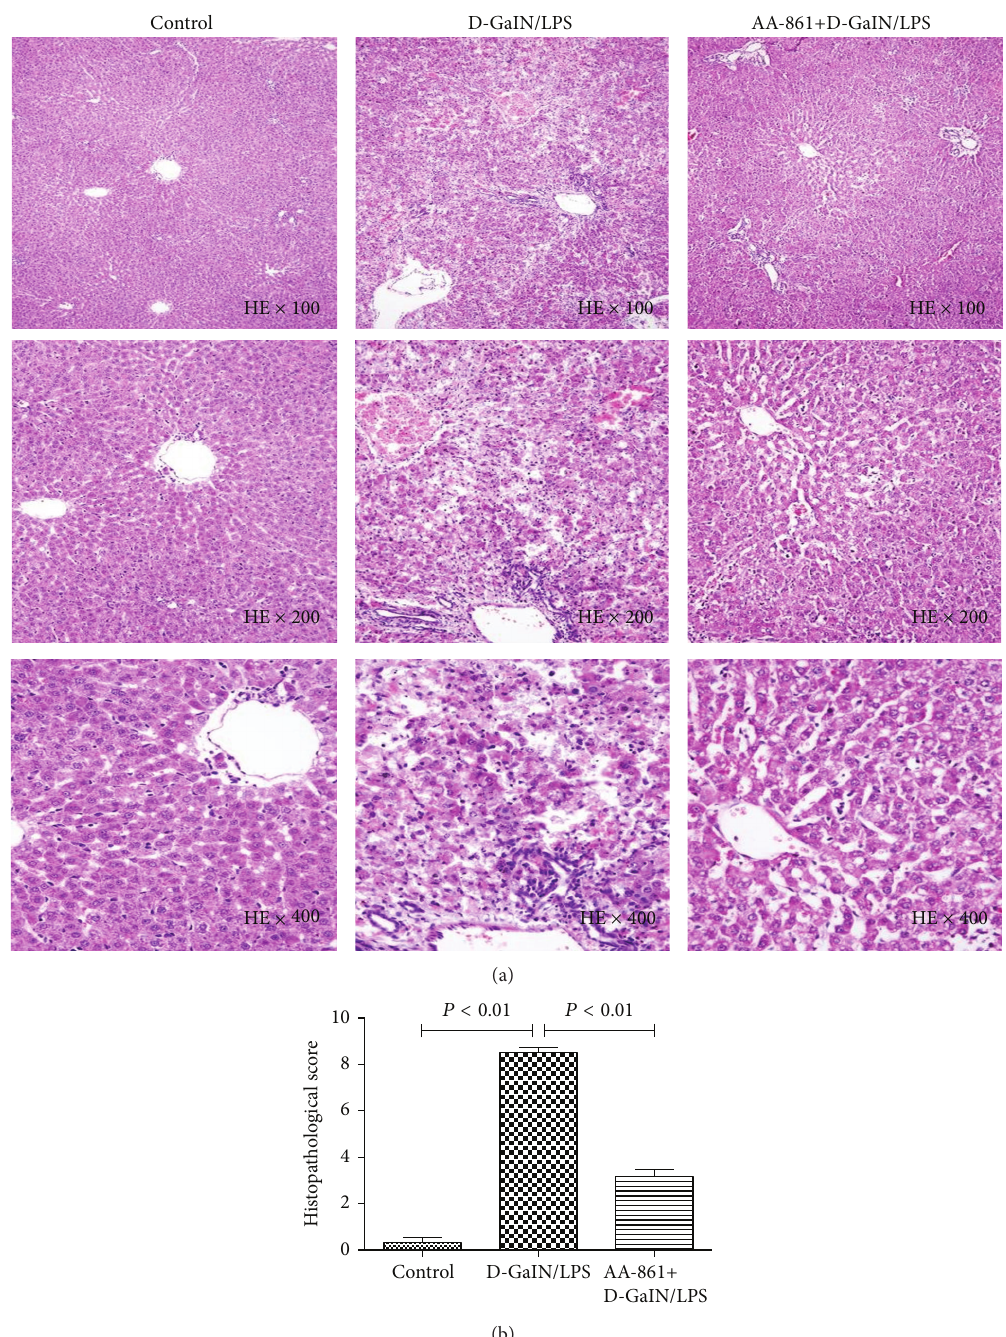
Figure 1: 5-LO specific inhibitor AA-861 prevented hepatocellular necrosis in D-GalN/LPS-treated rats. Representative photomicrographs of liver sections stained with hematoxylin and eosin from the control group receiving placebo (left panels), 24 hr D-GalN/LPS-treated rats receiving placebo (middle panels), and 24 hr D-GalN/LPS-treated rats receiving AA-861 (right panels). Confluent necrosis score and spotty lytic necrosis, apoptosis, and focal inflammation score in Modified Histological Activity Index system were employed. Control: 0; D-GalN/LPS: 9; AA-861 + D-GalN/LPS: